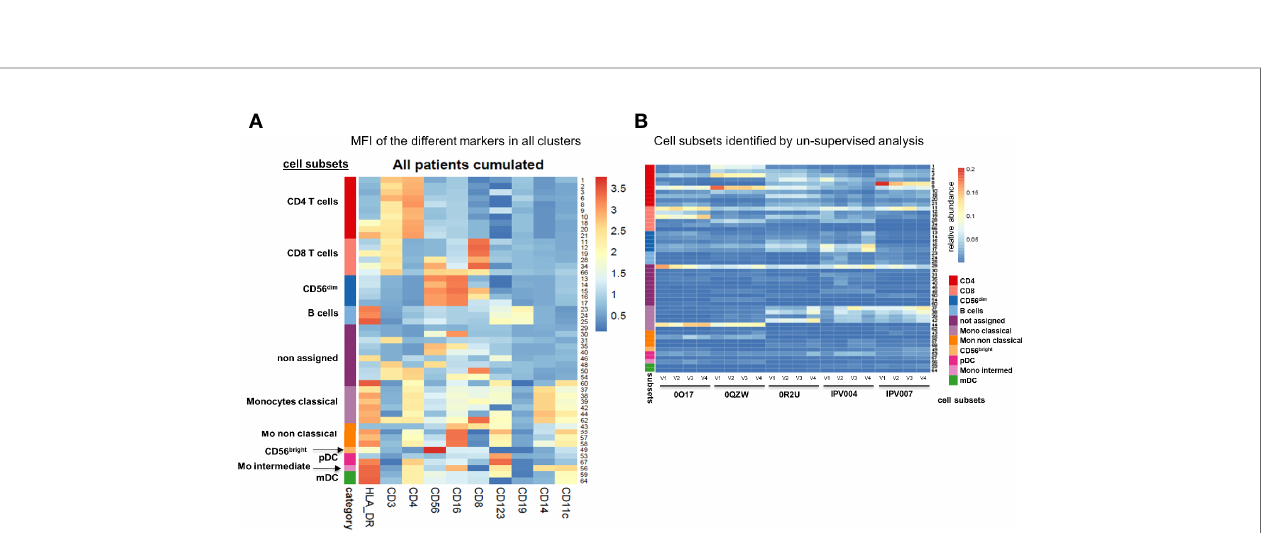
FIGURE 1 | Study design and cross-comparison between supervised and un-supervised data analysis. (A) Study design. Longitudinal blood samples were taken from patients initiating treatment. Peripheral blood mononuclear cells were labelled with an antibody panel and FACS data were processed in parallel with a supervised and an un-supervised data analysis. The cross-comparison of data lead to data-driven revised gating strategy and discovery. (B) Representative example of the supervised gating and analysis strategy of fl ow cytometry data. Arrows describe the hierarchical sequences of analysis ( i.e. gating strategy). Identi fi ed cell subsets: lymphocytes (I), T cells (III) (CD3 + CD19 - ), CD4 + (IV) and CD8 + (V) T cells, B cells (VI) (CD19 + CD3 - ), cytokine secreting NK bright (VII) (CD56 hi CD16 + / - ) and cytotoxic NK dim (VIII) (CD56 dim CD16 + ) NK cells, mDCs (IX) (CD123 - CD11c + ) and pDCs (X) (CD123 + CD11c - ); monocytes (II): classical (XI) (CD14 + CD16 - ), intermediate (XIII) (CD14 + / - CD16 + / - ) and non-classical monocytes (XII) (CD14 - CD16 + ). Ten cell subsets are identi fi ed and highlighted with a red dotted frame. (C) Heatmap representation of the frequencies of the 10 different prede fi ned cell subsets per patient and time point after supervised data